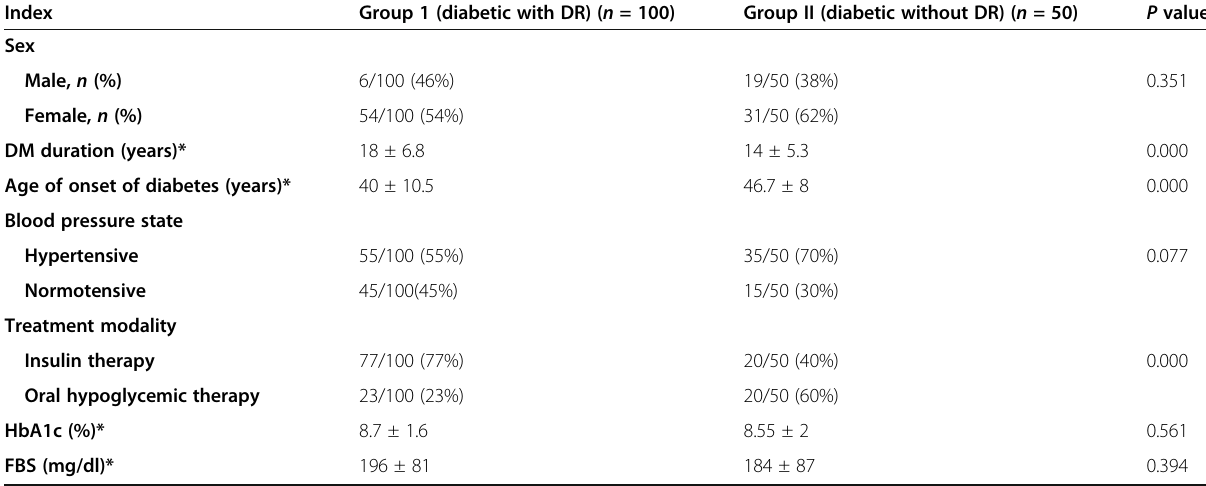
Table 1 Comparison of demographic and laboratory data of diabetic with DR group and diabetic without DR group